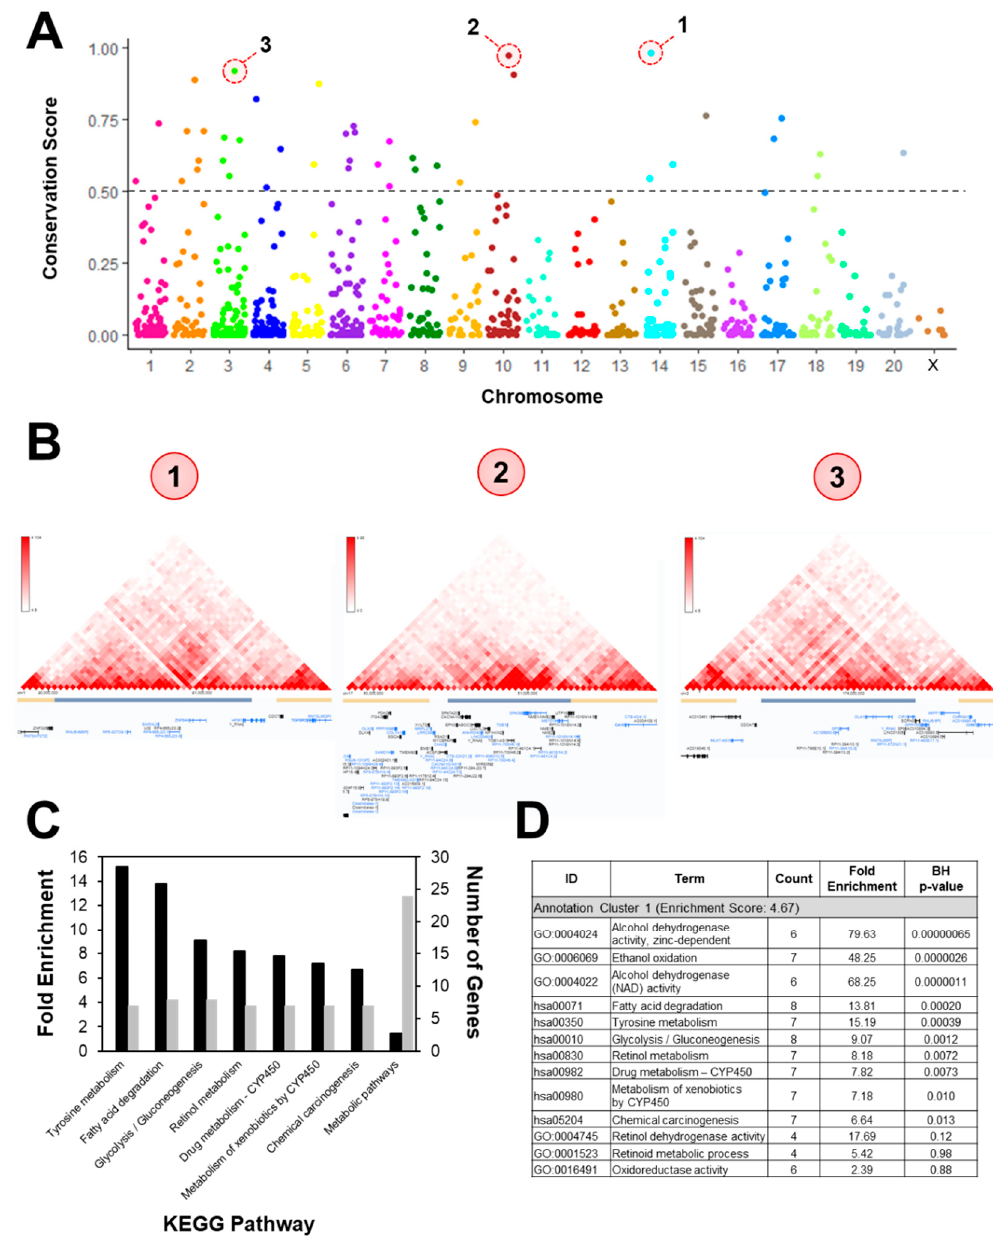
Figure 6. Intergenic DMRs in conserved genomic regions were associated with metabolic genes through chromatin contacts. ( A ) The conservation score was calculated for every intergenic DMR and only those with scores > 0.5 were considered for further analysis ( n = 42). ( B ) Regions from the Rn4 genome build were aligned with the Hg38 genome and queried for chromatin contacts. As an example, contact maps are shown for the three DMRs with the highest conservation scores. Genes located within the DMR-associated topologically associated domain (TAD; gray bars) were used for functional analysis. ( C ) KEGG Pathway analysis and ( D ) functional clustering showed enrichment for metabolic